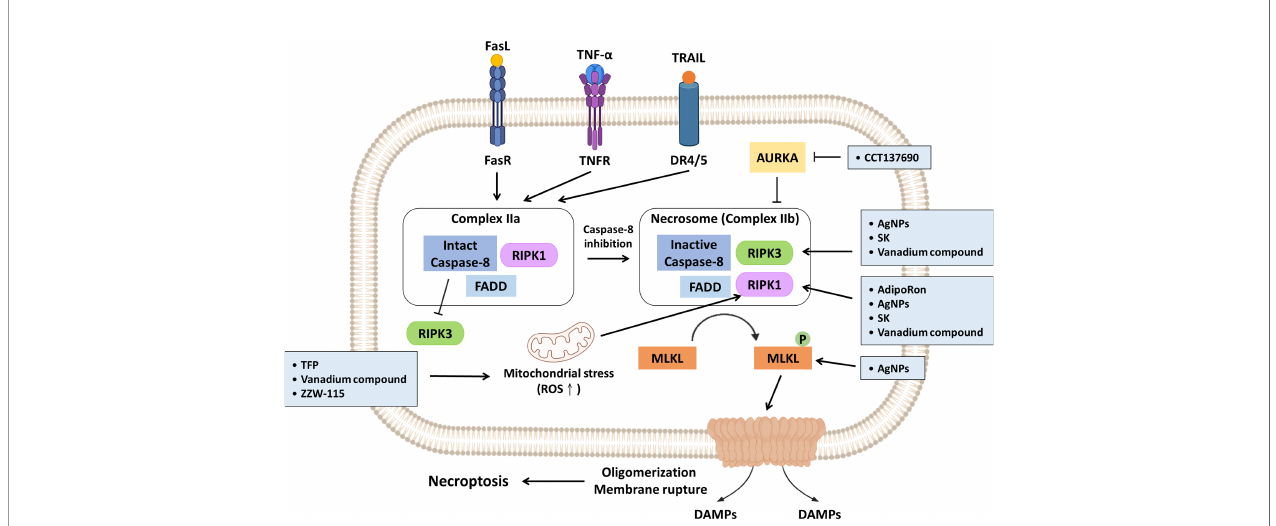
FIGURE 2 | Promising strategies inhibit PDAC progression via necroptosis induction. Necroptosis induction is primarily executed by RIPK1, RIPK3 and MLKL. Mitochondrial ROS can facilitate autophosphorylation of RIPK1 and subsequent initiation of necroptosis. TFP, vanadium compound and ZZW-115 have been reported to trigger necroptosis by enhancing mitochondrial stress accompanying increased ROS generation. Aurora kinase A (AUKRA) is a serine/threonine kinase that directly suppresses necrosomes; CCT137690 drives necrosome formation and necroptosis through AUKRA inhibition. AdipoRon, AgNPs, SK and vanadium compounds activate RIPK1; AgNPs, SK and vanadium compounds promote RIPK3 expression. In addition, AgNPs can also directly induce MLKL. The promising strategies are summarized in light blue